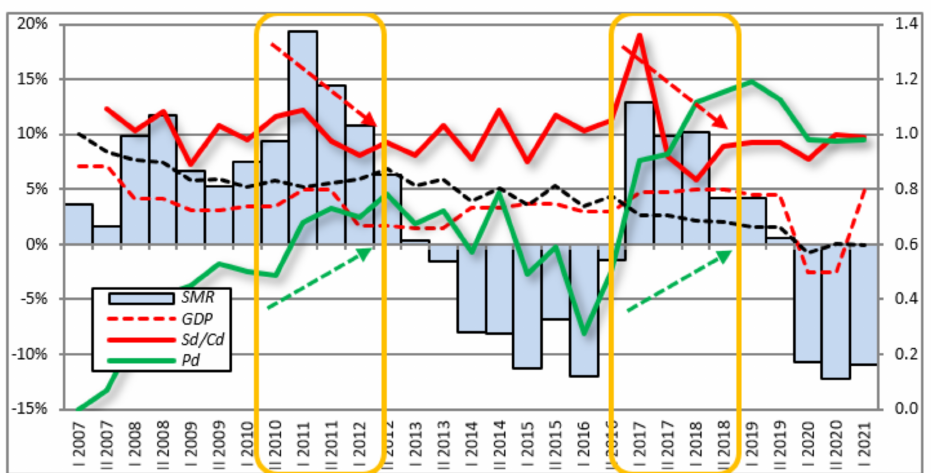
Figure 9. Sales margin rate ( SMR ), coal price dynamics ( Pd ), output dynamics ( Qd ), dynamics of revenue from sales to costs ( Sd/Cd ) in coal mining companies in 2007–2019 (data for six months). Note: SMR , GDP —left axis. Source: as in Figure